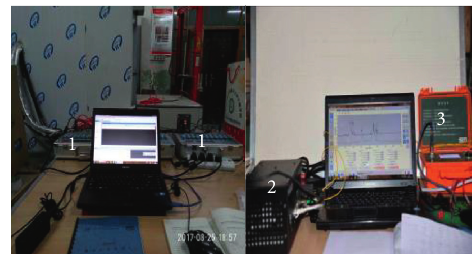
Figure 5: Data acquisition system. 1: static strain gauge, 2: optical sensing interrogator, and 3: vibrating string reader.